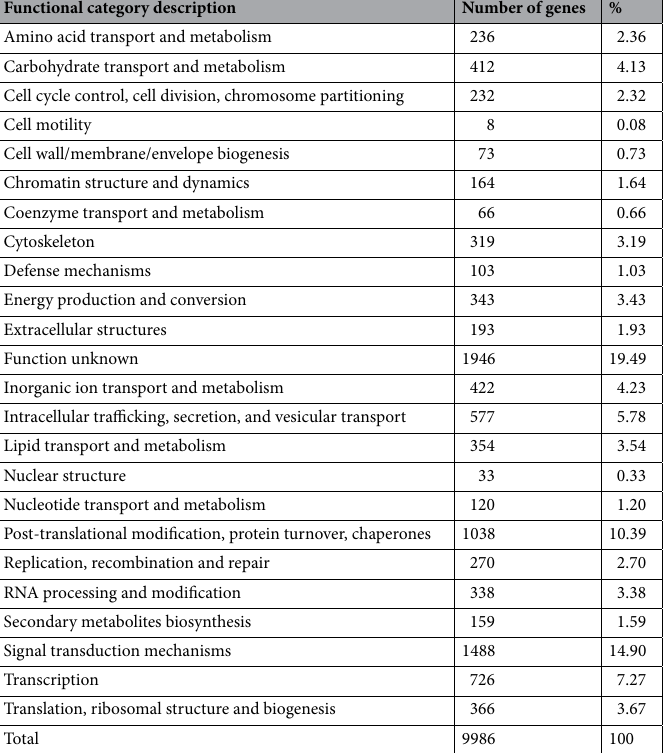
Table 1. Functional annotation of Strongyloides stercoralis sequences. Functional description and number of genes belonging to each eggNOG sub-category are